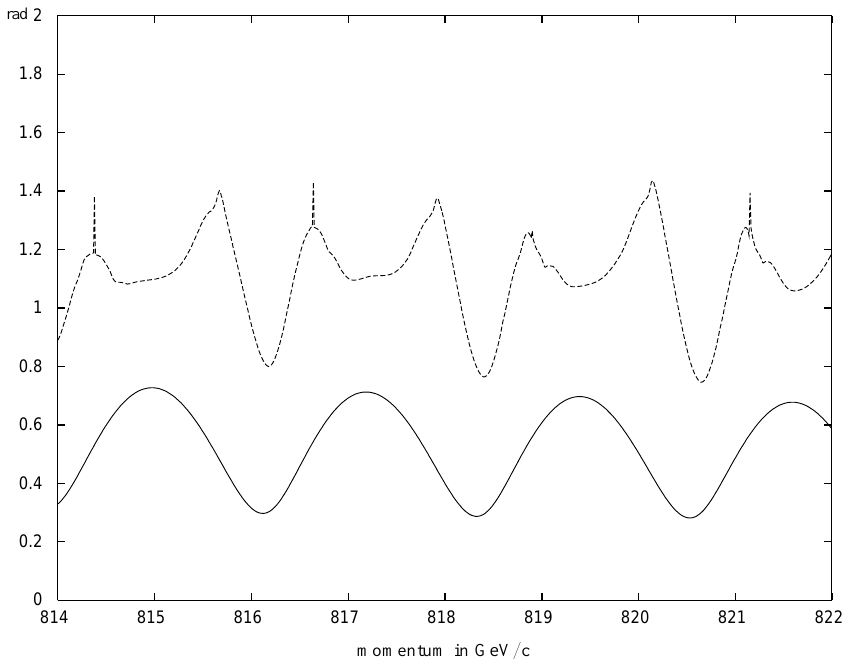
FIG. 5. SPRINT opening angles for a beam with normalized vertical emittance of 32 p mm mrad in HERA (dashed line) and 4 p mmmrad (solid line). Higher-order resonance peaks appear with increasing emittance. First-order resonance peaks were avoided by fixing the spin tune to n 0 (cid:1) 1 (cid:1) 2 with Siberian snakes.